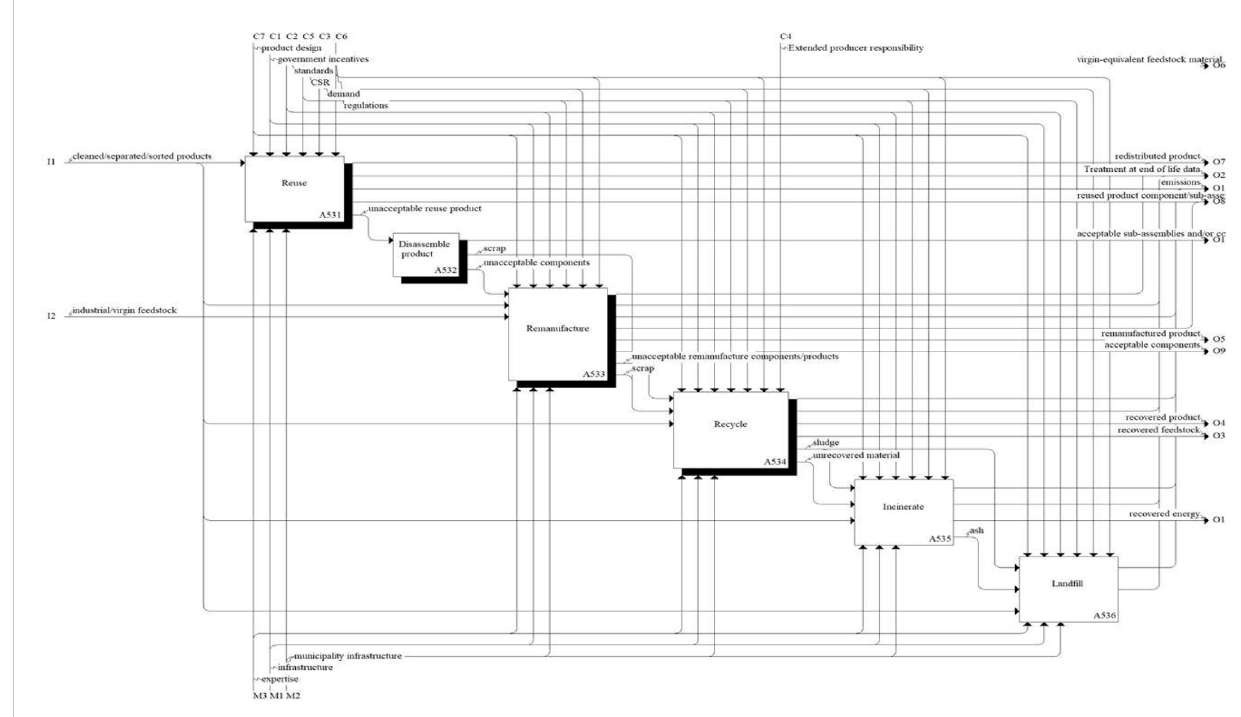
A53 Treat EoL products phase in the context of a manufacturing CE IDEF0